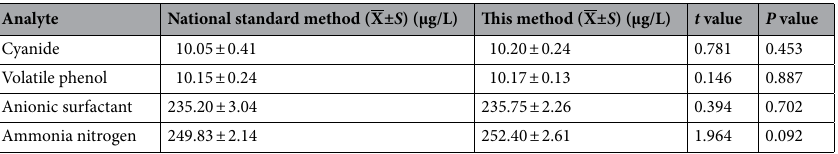
Table 4. Comparison of determination results between national standard method and this